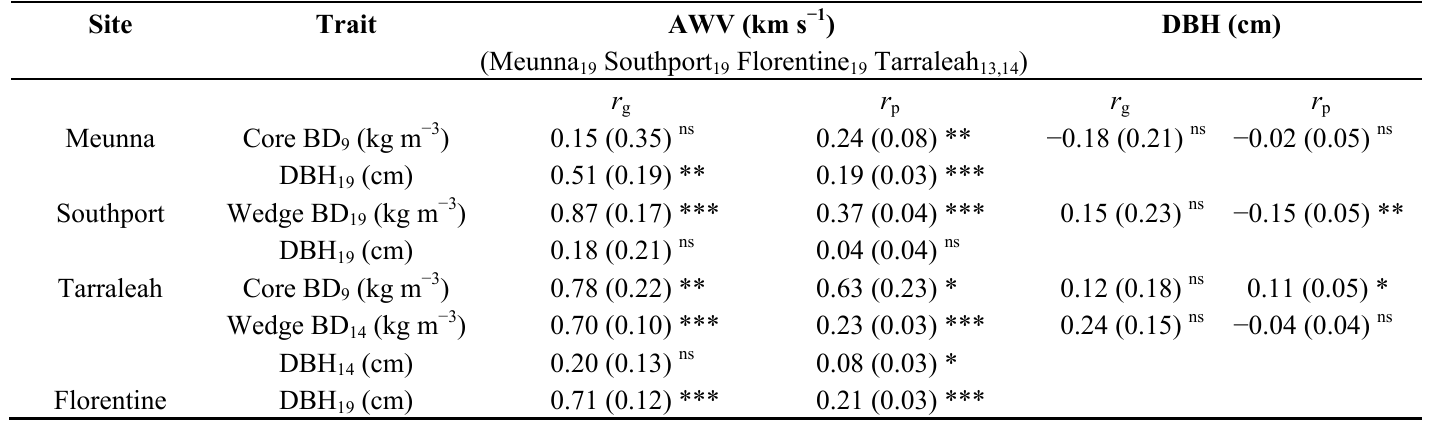
Table 6. Inter-trait additive genetic ( r ) and phenotypic ( r ) correlations among acoustic wave velocity (AWV), basic density (BD) and g p diameter at breast height (DBH; 1.3 m) within each of the four Eucalyptus nitens progeny trial sites (standard errors shown in parentheses). The significance shown is for the test from zero. Trial age in years of each trait assessment is shown as subscripted